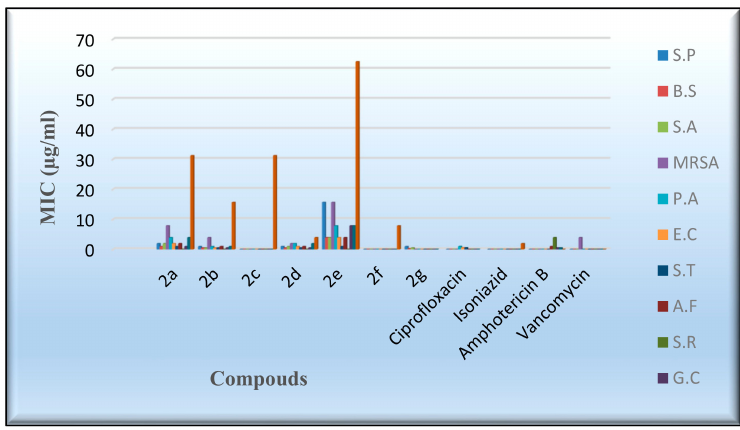
Figure 6. Evaluation of the IZ values of the synthesized derivatives.